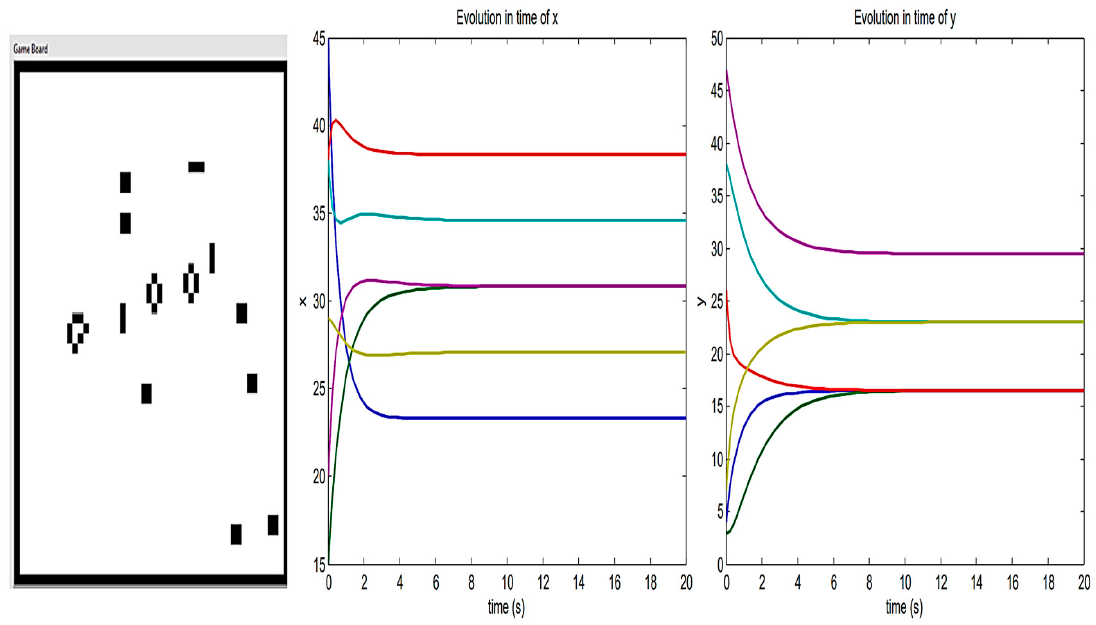
Figure 4. Evolution in time of the coordinates with distributed formation control.